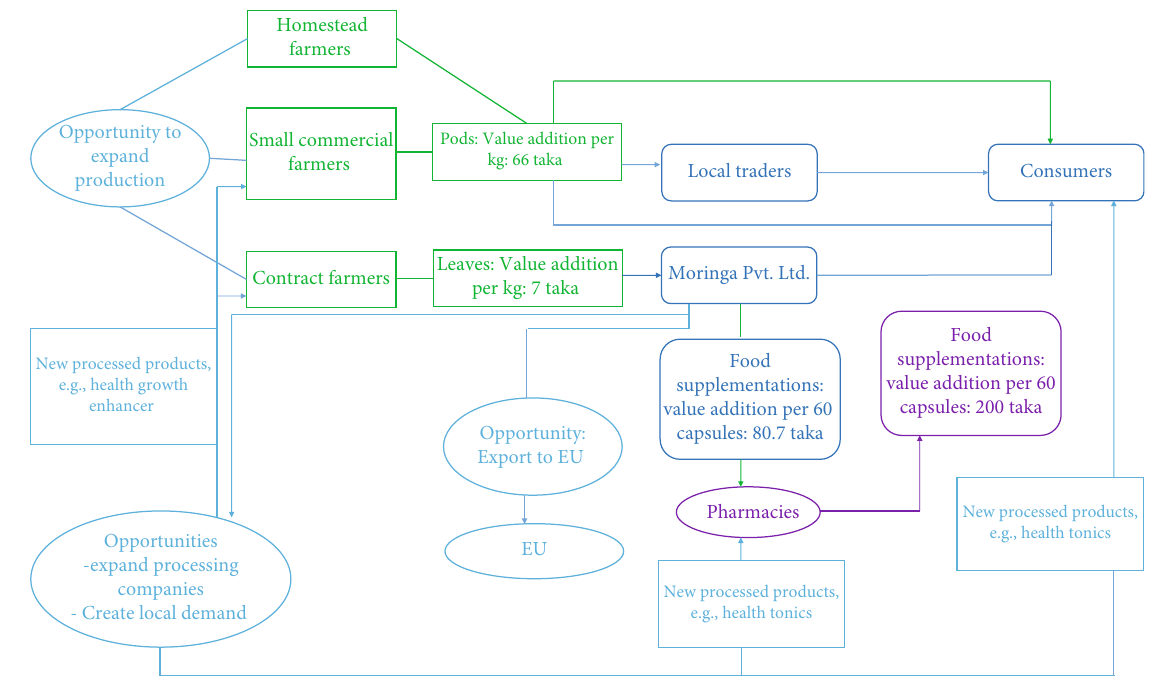
Figure 2: Market map of the current value chain and future opportunities in Bangladesh. Table 1: Categories of Moringa